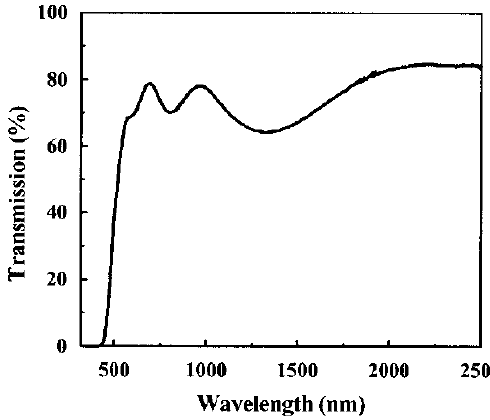
FIGURE 4 Transmission spectrum of V 2 O 5 thin films spin-coated at